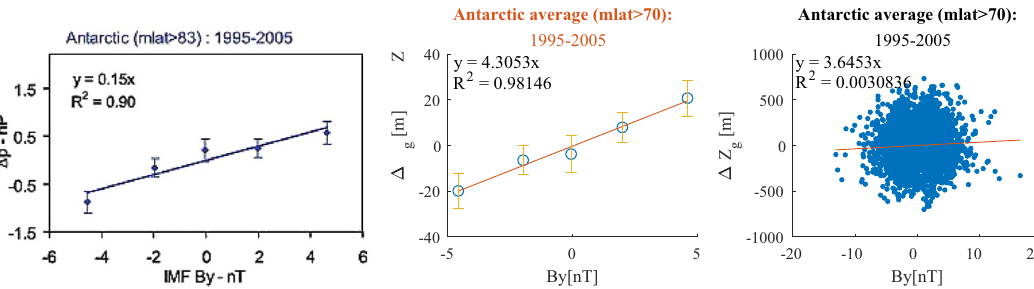
Fig. 3. Left panel : A copy of the upper panel of Figure 1 in B2008. It represents linear regression of D p after the original measurement from three Antarctic stations at mlat >83 (cid:3) S was grouped according to the IMF B y . Middle panel : Reproduction of the linear regression method using D Z (cid:3) S. Error bars are plus/minus one standard-error-in-the-mean. Right panel : Scatter plot and linear regression for the D Z g at ~mlat >70 without the initial fi ve-bin grouping. The upper panel of Figure 1 in B2008 is reproduced with permission from John Wiley and